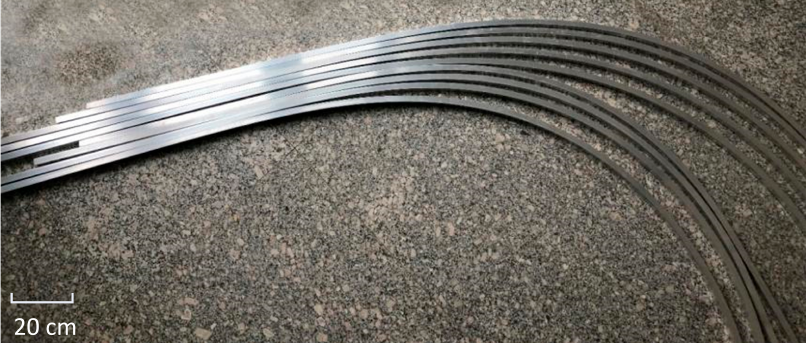
Figure 12. Partially variable-curvature experimental profiles.